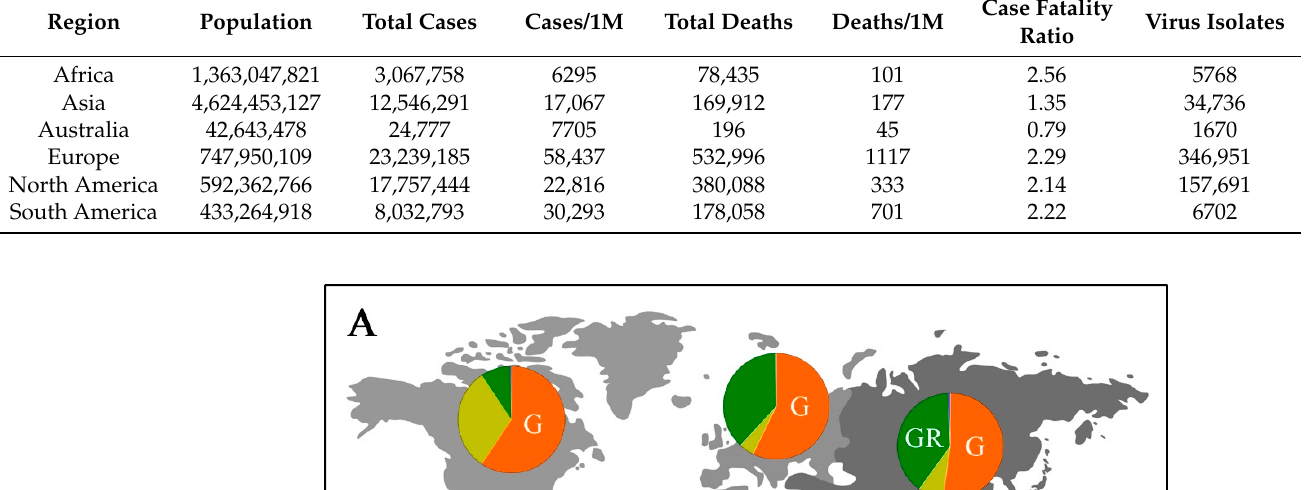
Table 1. COVID-19 statistics in the different world continents.